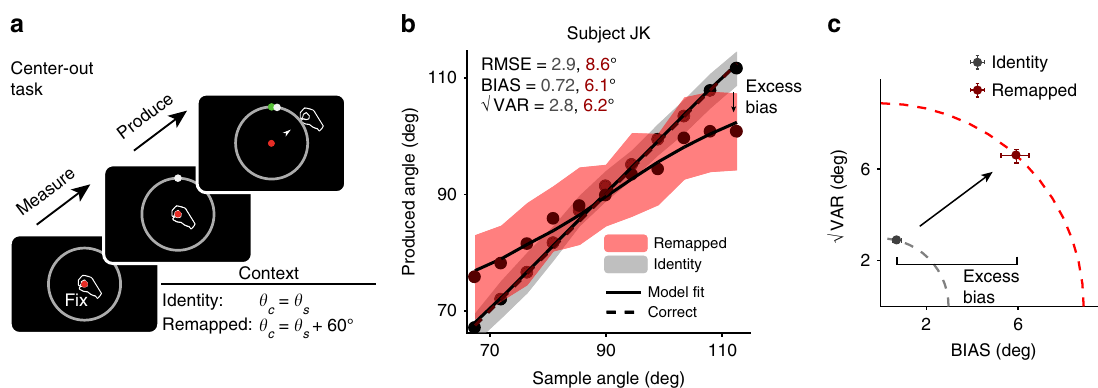
Fig. 6 Center-out reaching task, visuomotor rotation = 0 and 60°. a Trial structure. While holding fi xation on a central spot on an upwards facing monitor, subjects viewed a sample angle de fi ned by the position of a small circle brie fl y fl ashed on a larger perimeter circle. Subjects then produced an angle by moving a handheld bar outward through the perimeter circle. In the “ remapped ” context (pictured), the response cursor was rotated 60° counterclockwise around the center of the circle relative to hand position such that correct angle θ c = θ s + 60°. The positions of the targets on the screen were identical across contexts. b Performance of an example subject in the identity (gray) and remapped (red) contexts (same format as Fig. 2). Similar to other tasks, the subject ’ s behavior showed excess bias beyond what was predicted assuming no additional MTN (i.e., equal to the identity context). Shaded regions show mean ± one standard deviation. c √ VAR vs. BIAS plot shown in the same format as Fig. 2c. RMSE in the remapped context was larger than predicted